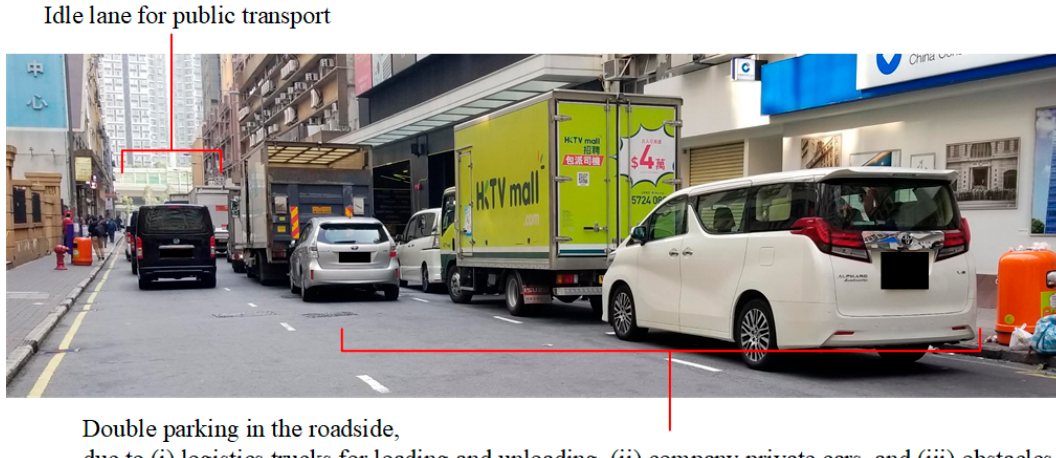
Figure 1. On-site roadside example of double-parking.